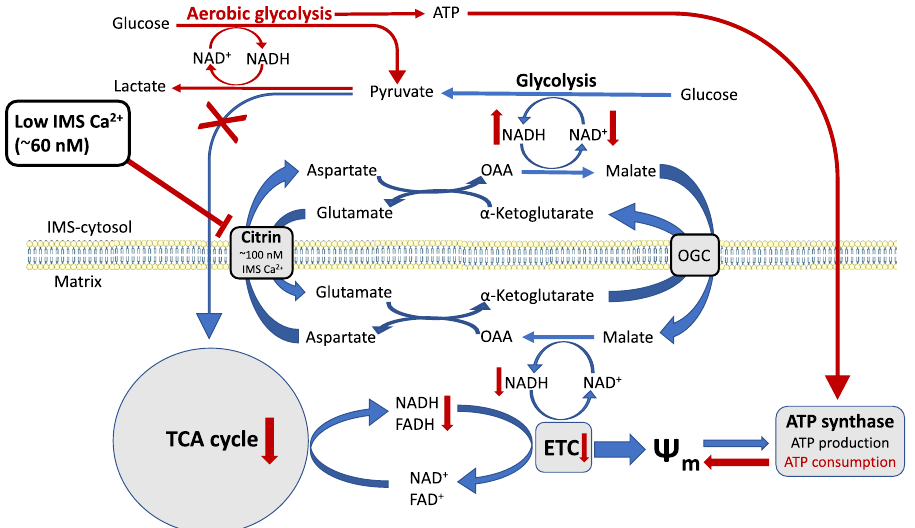
Fig. 9 Schematic representation of IMS Ca 2 + homeostasis as fundamental regulator of resting cytosolic and mitochondrial metabolism. IMS Ca 2 + modulates citrin/malate-aspartate shuttle activity with basal IMS Ca 2 + level being set at around 100 nM by ER-mitochondrial Ca 2 + fl ux. Main processes that are regulated by basal IMS Ca 2 + driven MAS activity are shown with blue arrows, and consist of MAS recycling NAD + for glycolysis and glycolytic products going through TCA cycle and ETC. Disruption of this Ca 2 + homeostasis leads to metabolic rewiring, shown here with red arrows and text. As a result, cells switch to aerobic glycolysis, rely on LDH for NADH recycling, and have reduced OxPhos. OAA, oxaloacetate; OGC, oxoglutarate/malate carrier